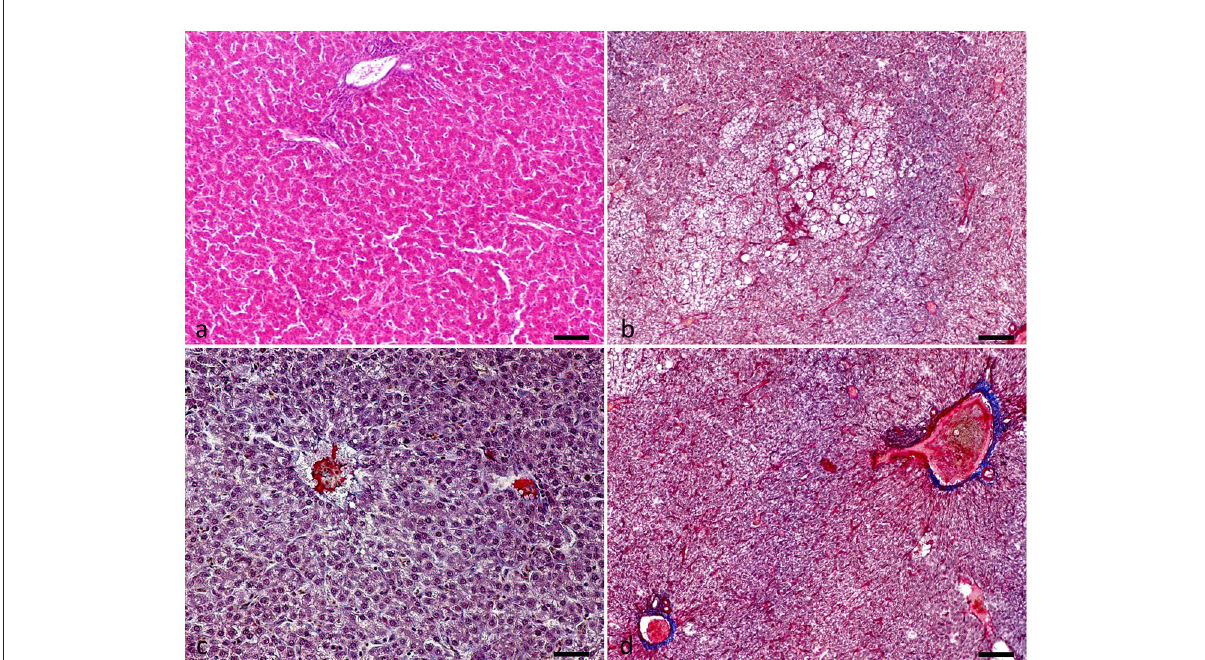
FIGURE3 Liver evaluation of hens at the end of the experimental period (week 32). (a) Normal liver tissue, (b–d) Presence of intravascular organized fibrin consistent with the formation of thrombi, degeneration, and necrosis of hepatic cells with micro-hemorrhages. Hematoxylin and Eosin (a) . Martius-Scarlet-Blue (b–d) . Scale bar: 250 µ m.